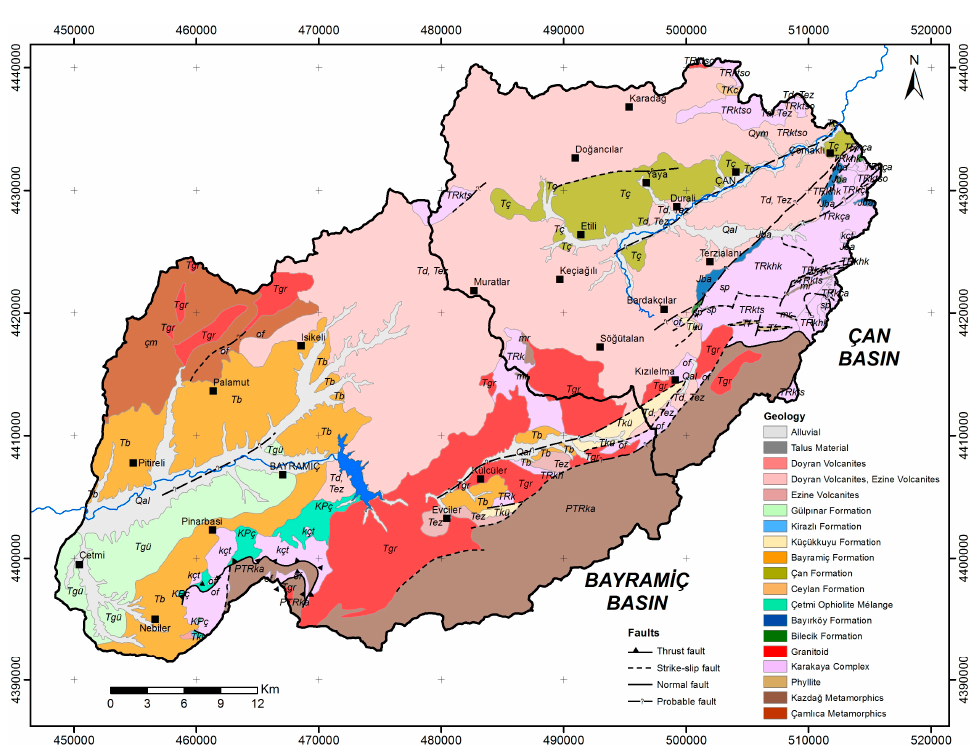
Figure 2. Geology of study area.